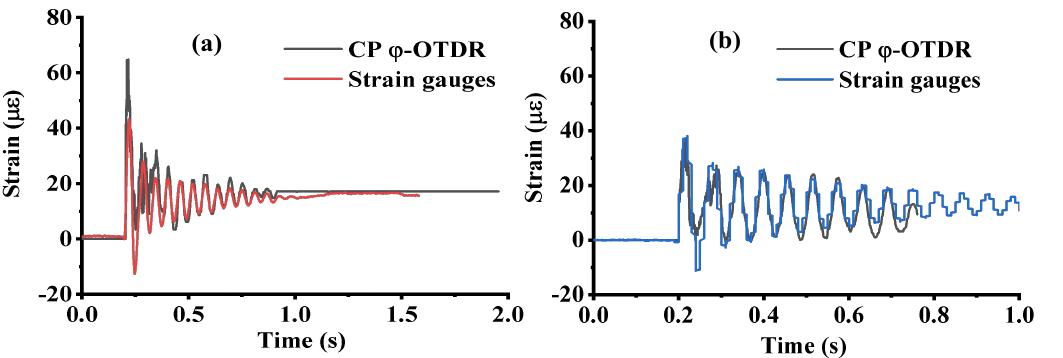
Figure 5. Strain–time response comparison between a CP ϕ − OTDR and strain gauge at midspan with different spatial resolutions of ( a ) 0.8 m and ( b ) 1